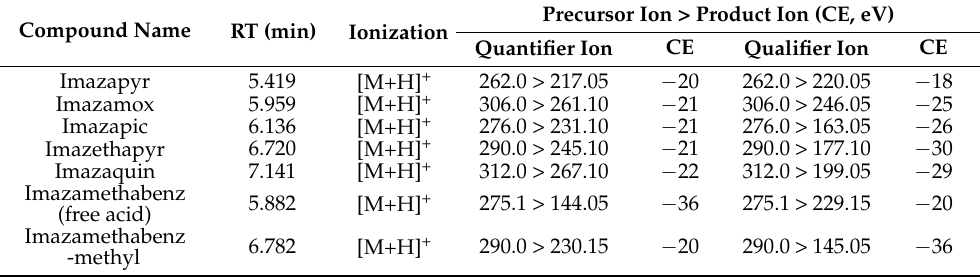
Table 2. Optimized MRM parameters for the determination of imidazolinone